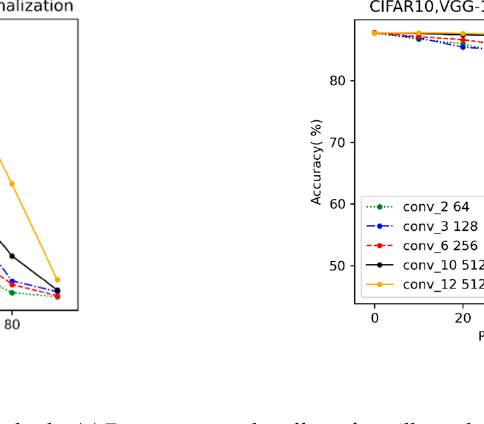
Figure 8. Comparison of two evaluation methods. ( a ) Demonstrates the effect of vanilla evaluation. ( b ) Shows the evaluation effect after incorporating Adaptive BN.